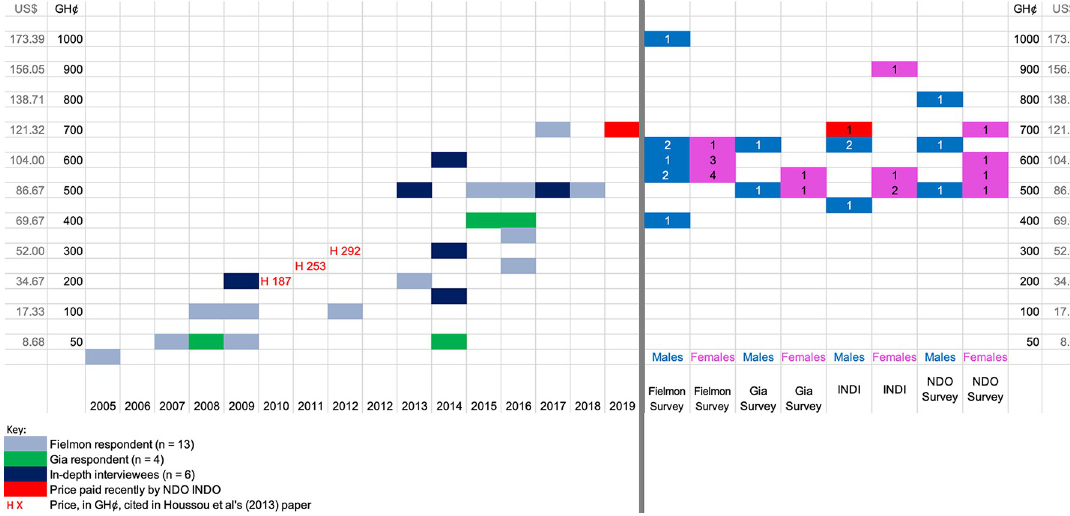
Fig 8. A: How much did you pay for your first donkey? When was that? (n = 24) B: How much do you have to pay for a donkey now? (n = 34). (Source: Maggs, 2022 [1]). Missing donkeys: Lost or stolen?. Over half of all DO and NDO respondents had person-